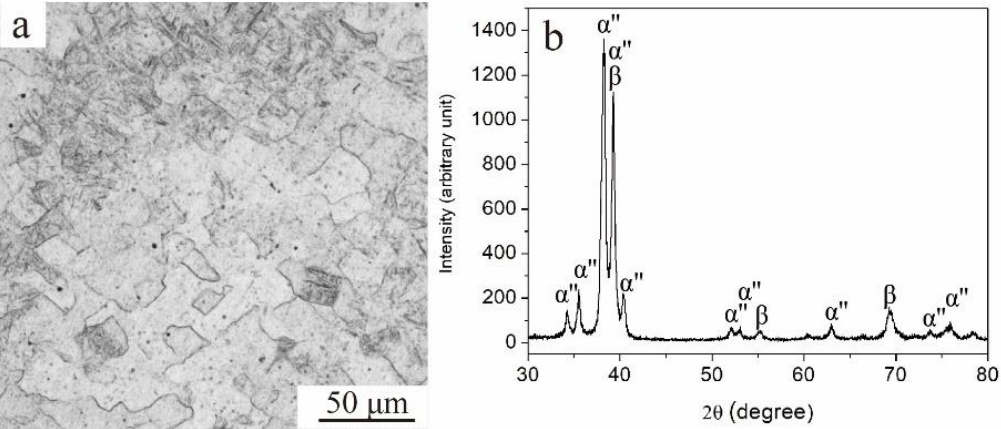
Figure 13. As-forged Ti6Al4V30Zr alloy: ( a ) Optical microscope image; ( b ) XRD pattern. Table 3. The chemical composition of titanium ingot (balance Ti, wt.%).